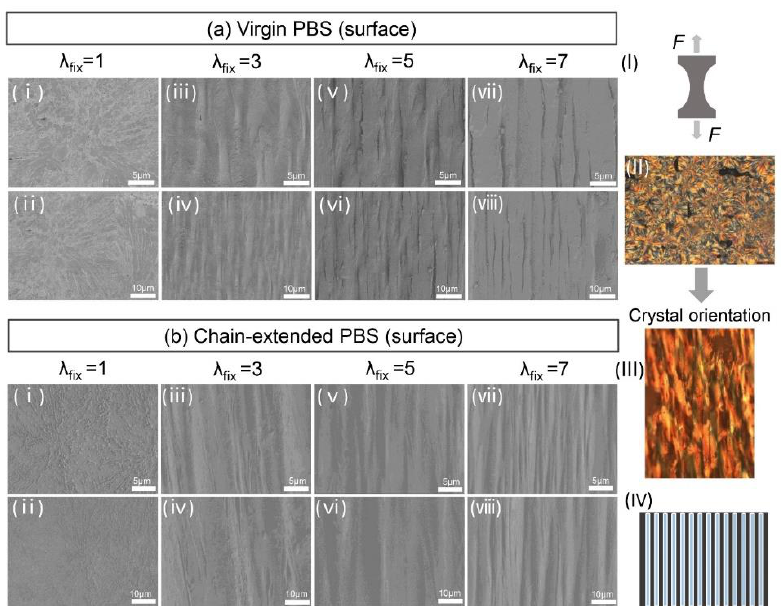
Figure 9. Scanning electron microscope analysis of orientated PBS before and after chain extension. The surface of virgin PBS ( a ) — ( ⅰ – ⅷ ) and chain-extended PBS ( b ) — ( ⅰ – ⅷ ) has as oriented spherular structure, ( ⅰ ) uniaxial tensile orientation diagram, ( ⅱ – ⅲ ) PLOM of spherulite structure change after crystal orientation, ( ⅳ ) structural diagram of the fibrous crystal.